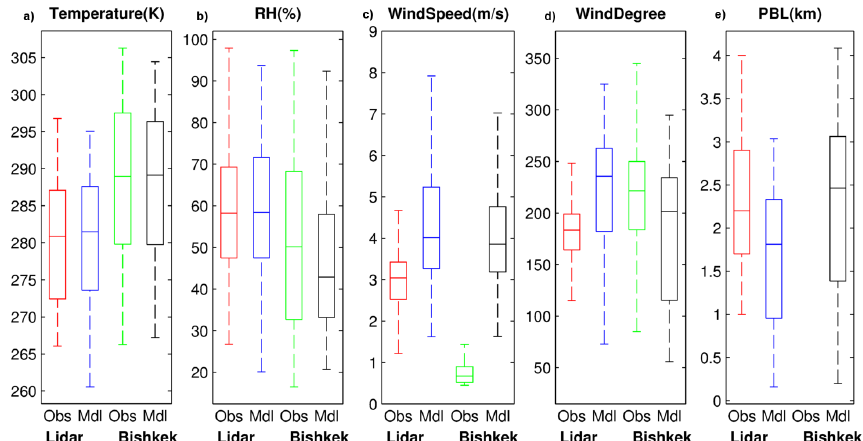
Figure 5. Comparison of predicted meteorological variables from WRF model with observations shown as box-and-whisker plots over the simulation period (a) temperature (K), (b) relative humidity (RH, %), (c) wind speed (ms − 1 ), (d) wind direction ( ◦ ), and (e) PBL height (m). “Lidar” denotes the LST site. In each box-and-whisker panel, the middle line denotes the median value, while the edges of the box represent 25th and 75th percentile values, respectively. The whiskers denote the maximum and minimum values.